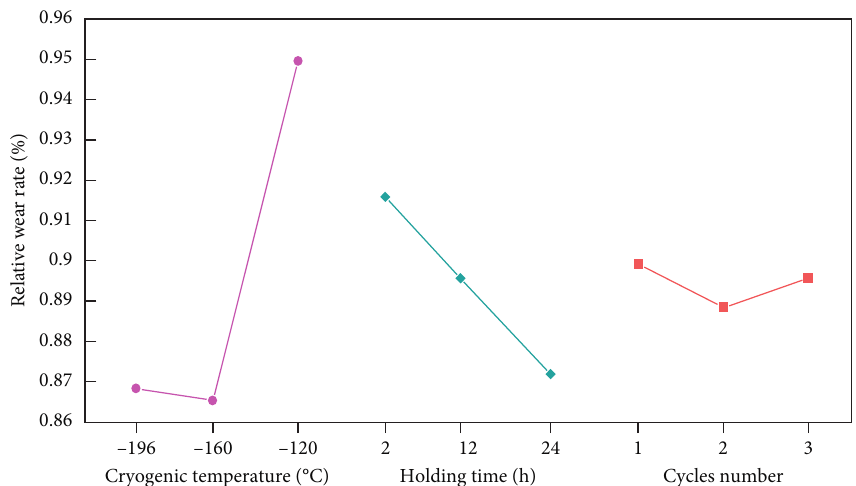
Figure 4: Relative wear rates against cryogenic temperature, holding time, and cycles